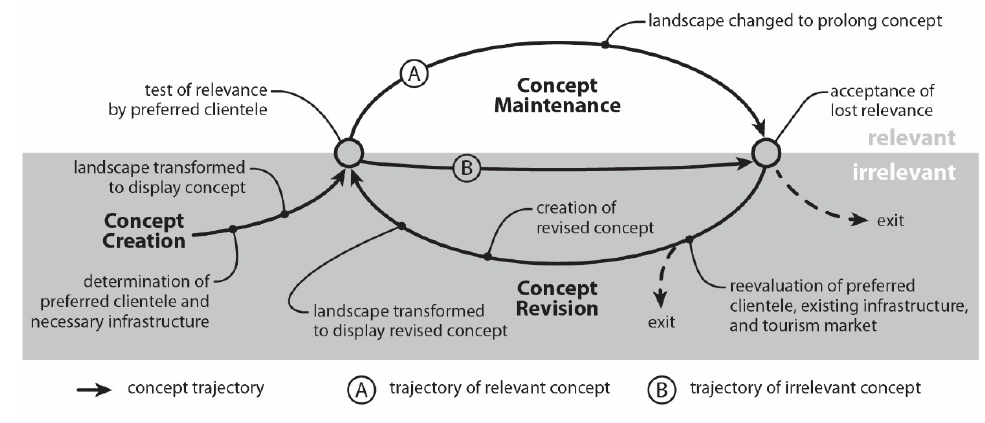
Figure 4. Concept Renewal Cycle Diagram. Source: Author.